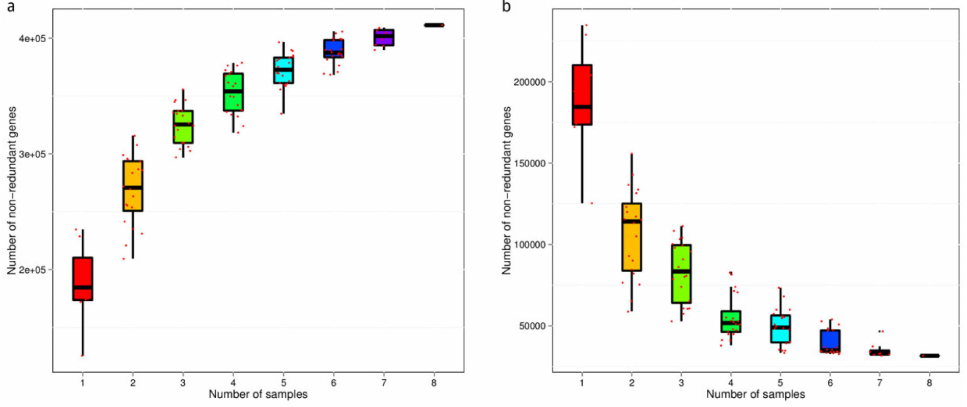
Figure 3. Dilution curve of the core and pan genes. ( a ) Pan gene dilution curve. ( b ) Core gene dilution curve. The abscissa indicates the number of samples. The vertical axis represents the number of genes in the samples (1–8: A–G). 4E+5: 4 × 10 5 , Same with the